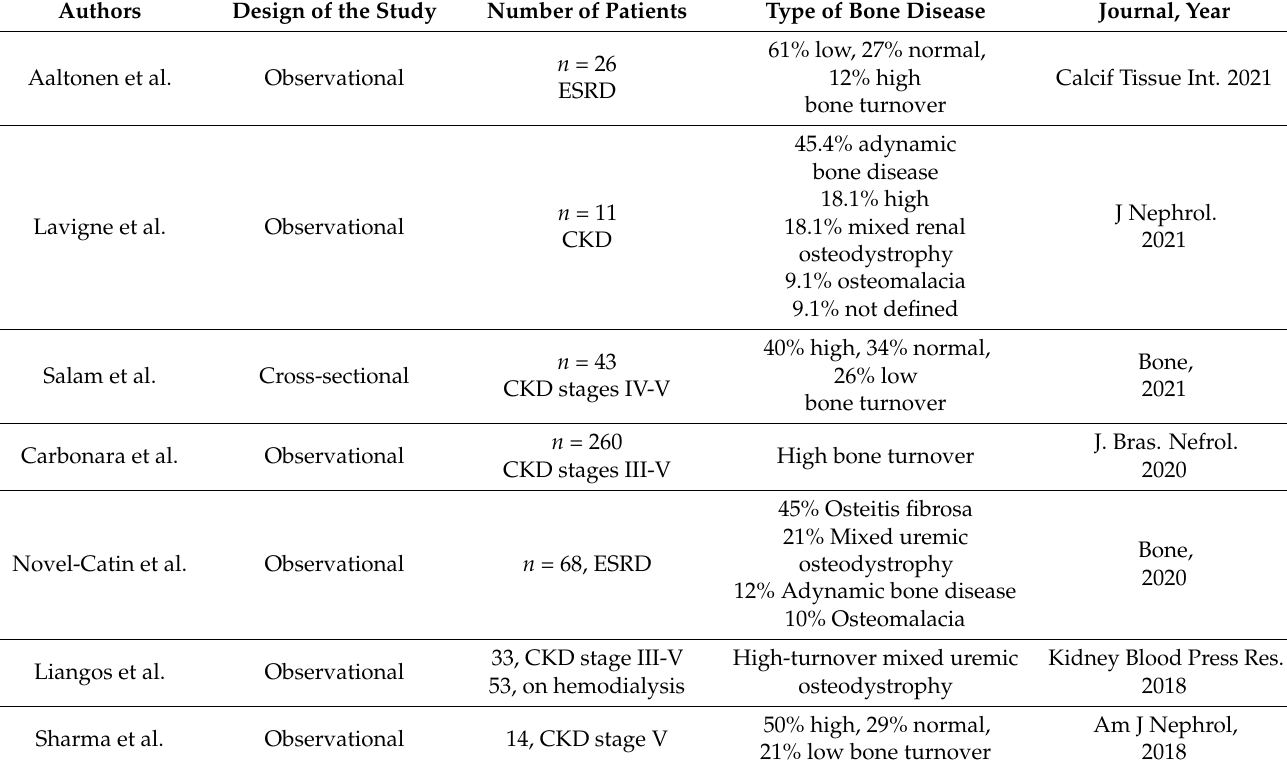
Table 1. The main literature on bone biopsy in recent decades.